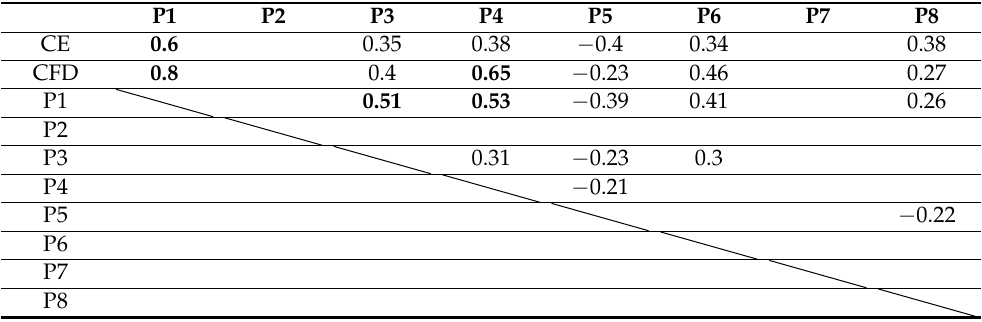
Table 4. CE, CFD levels versus Participants answers—correlation matrix for Frac images. Highest values are highlighted in bold. P1 P2